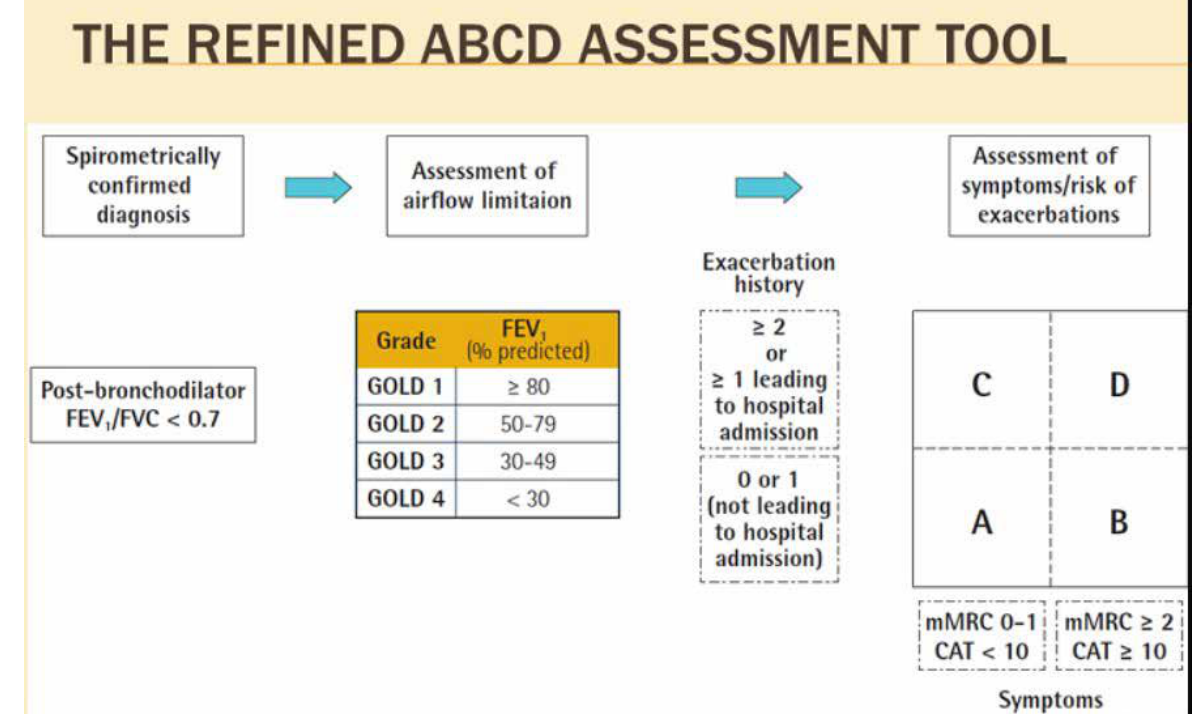
Figure 1: The refined ABCD assessment